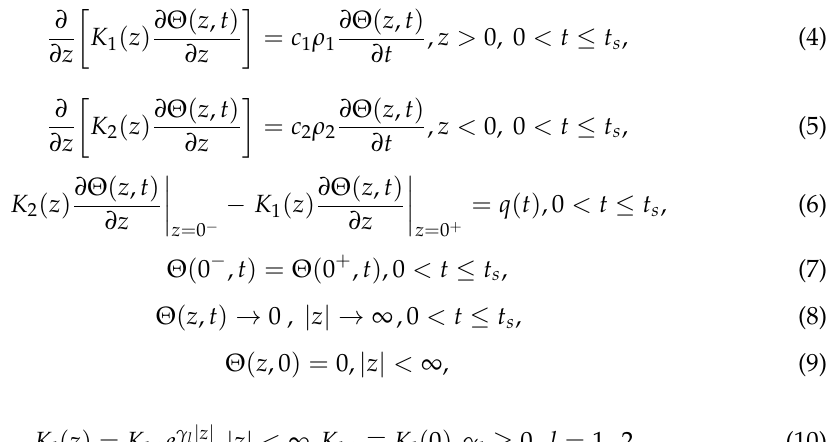
where where and function q ( t ) has the form expressed in Equation (3). Here and further, the subscript l indicates the parameters and quantities related to the certain element— l = 1 for the